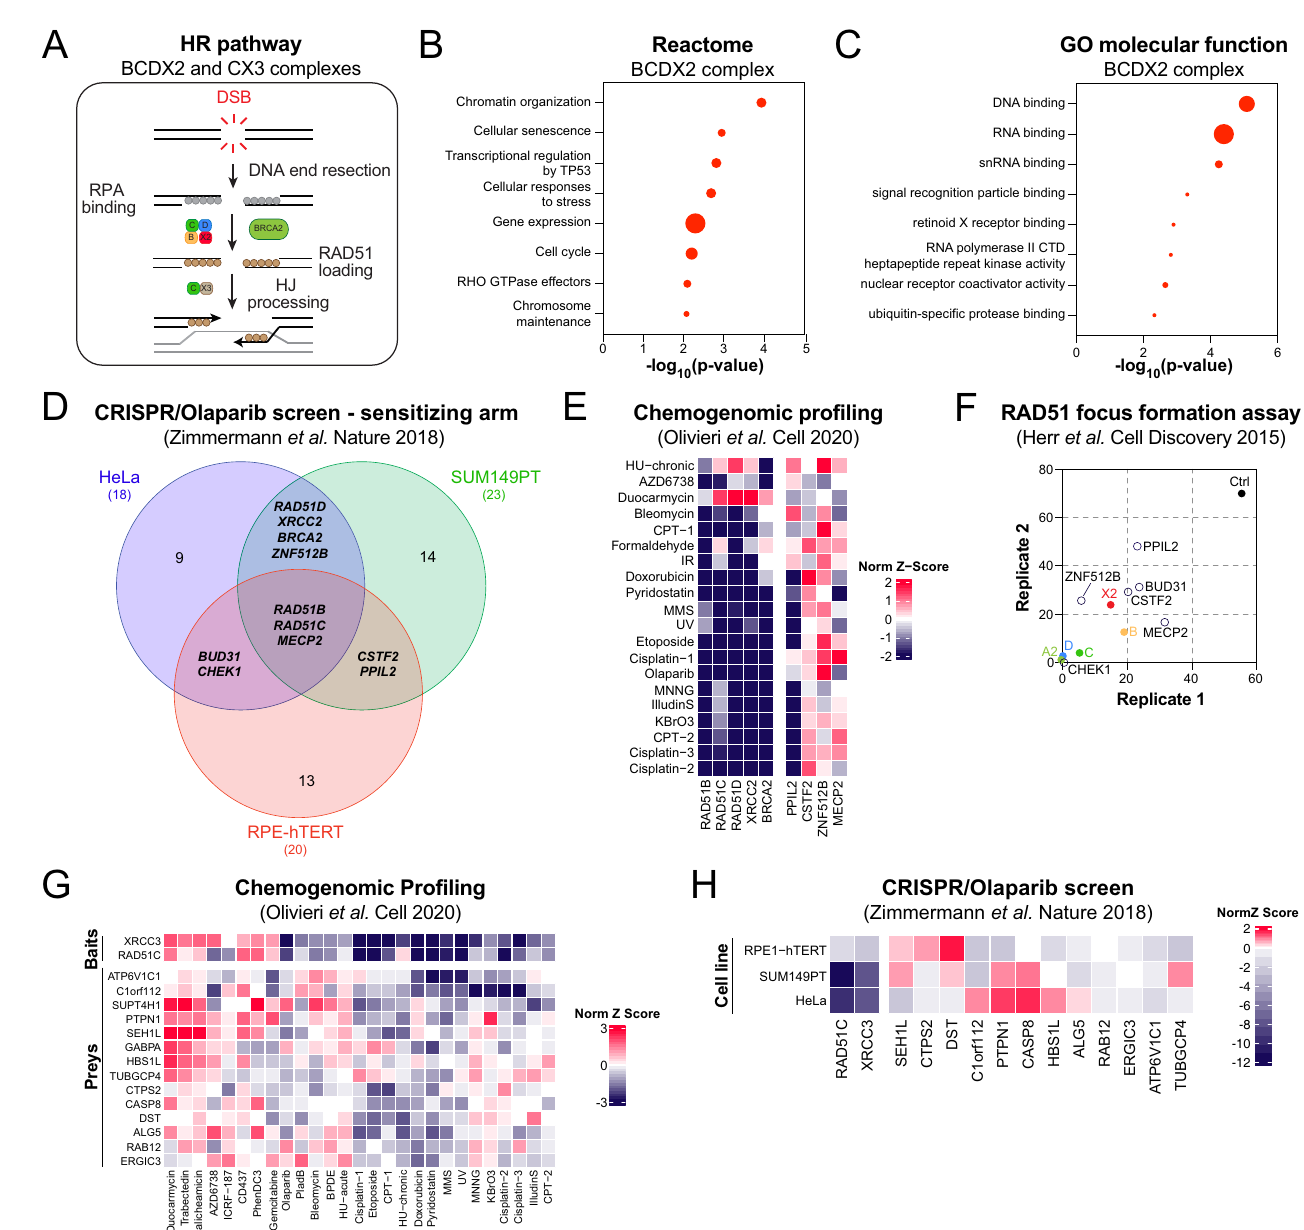
Fig 2. Proximal mapping of the BCDX2 and CX3 complexes. (A) Schematic representing the different steps of the HR pathway and the sequential involvement of the BCDX2 and CX3 complexes during this process. (B) Pathway enrichment analysis of the preys that are exclusive to the BCDX2 complex using the Reactome database. Data are represented as the -log 10 of the p-value (log 10 (p-value)) calculated for each indicated pathway by Reactome. Each dot is proportional to the number of preys that belong to the indicated pathway. (C) GO molecular function analysis of the preys that are exclusive to the BCDX2 complex. Data are represented as the -log 10 of the p-value (log 10 (p-value)) calculated for each indicated pathway by GO algorithm. Each dot is proportional to the number of preys that belong to the indicated pathway. (D) Venn diagram representing the overlap of the CRISPR screens published by [24] where sensitivity to the PARPi olaparib was tested in three different cell lines. Only the genes whose inactivation by CRISPR provided a significant sensitization to olaparib (NormZ-score < 1) are plotted. (E) Heatmap clustering representing the NormZ-scores of our selected preys alongside the classical RAD51 paralogs in a series of CRISPR screens published by [23]. (F) Representation of the percentage of S/G2 U2OS cells transfected with the indicated siRNA and displaying more than 9 IR-induced RAD51 foci as published in [44]. Each replicate is plotted on the x- and y-axis. (G) Heatmap clustering representing the NormZ-scores of our selected preys alongside RAD51C and XRCC3 in a series of CRISPR screens published by [23]. (H) Heatmap clustering representing the NormZ-scores of our selected preys alongside RAD51C and XRCC3 in a series of CRISPR screens published by [24] where sensitivity to the PARPi olaparib was tested in three different cell